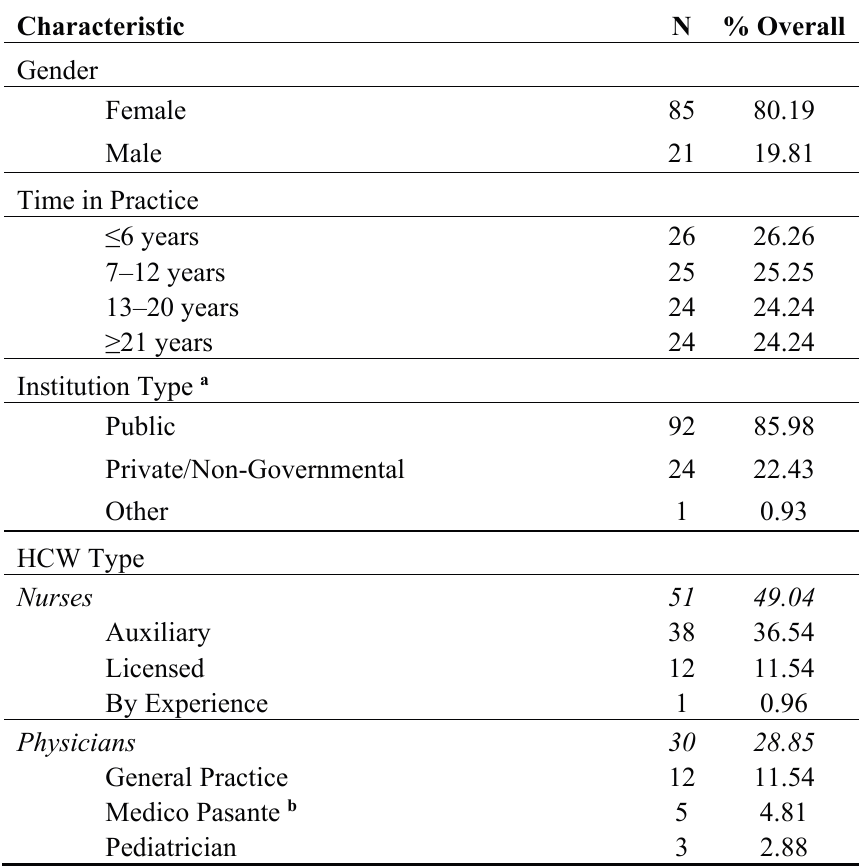
Table 1. Subject Characteristics ( N =